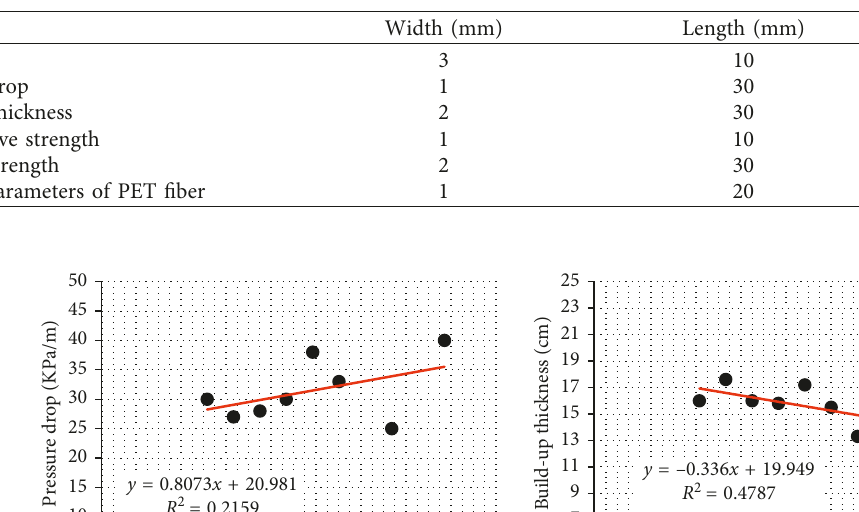
Table 7: Optimal parameters of PET fiber for wet-mix shotcrete.